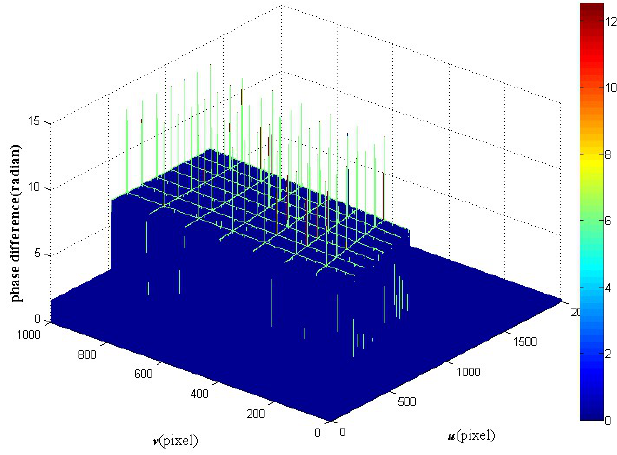
Figure 8. Two-dimensional (2D) phase-difference pulses of the horizontal/vertical fringe patterns.